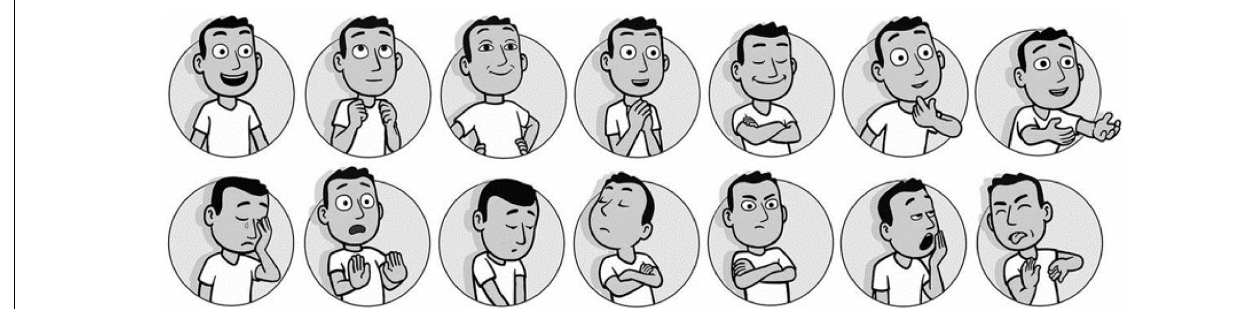
FIGURE 1 | Emotional indication measurement card.